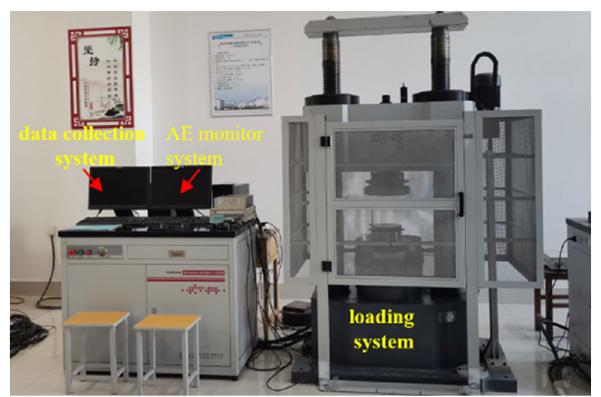
Figure 2. Specimen image of soft rock-like.